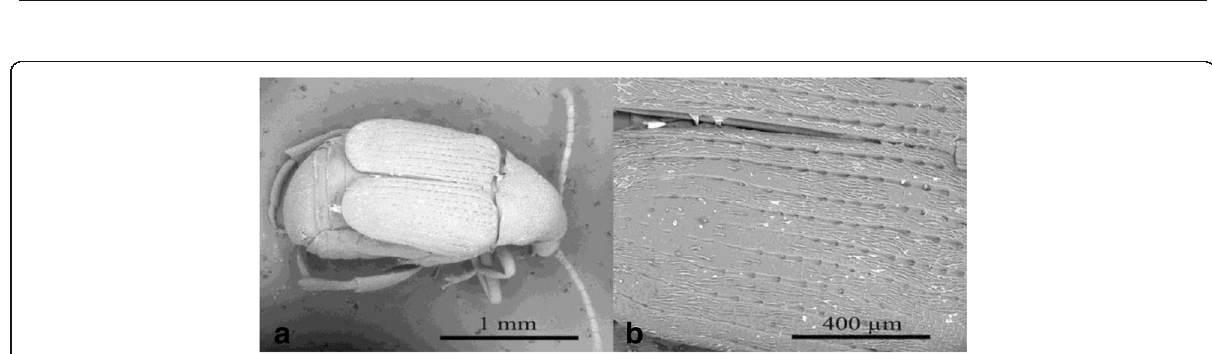
Fig. 4 Scanning electron microscope images of Callosobruchus maculatus adults exposed to untreated cowpea. a Dorsal view. b Section of dorsal view